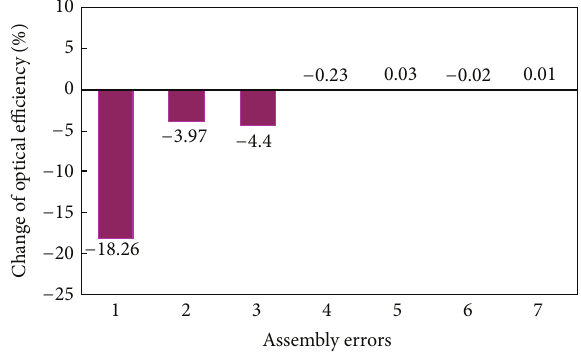
Figure 14: Change of optical efficiency under 7 assembly